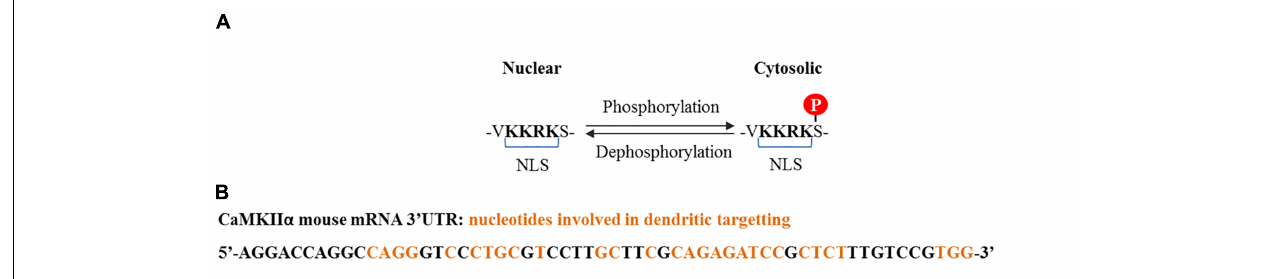
FIGURE 2 | CaMKII α nuclear localization signal and dendritic mRNA location sequences. (A) Nuclear localization signal contained by some splice variants from α , δ , and γ isoforms. Nuclear translocation is regulated by phosphorylation at the serine adjacent to the NLS. Phosphorylation at this serine by CaMKI and CaMKIV prevents CaMKII α and CaMKII δ nuclear translocation (Heist et al., 1998), whereas dephosphorylation, presumably by PP2A for CaMKII δ and PP2B (calcineurin) for CaMKII γ , promotes translocation (Zhang et al., 2002; Ma et al., 2014). (B) Common cis elements that have been shown to be involved in CaMKII α dendritic mRNA location and which are conserved among rat, mouse, and human (Mori et al.,